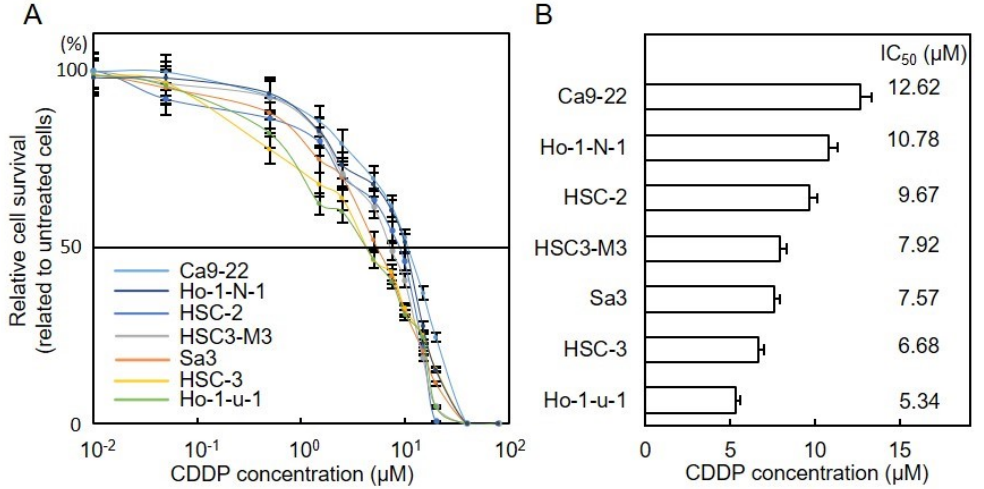
Figure 2. CDDP sensitivity of OSCC cells. ( A ) OSCC cells were seeded in 96-well plates at a density of 1 × 10 4 viable cells/well and treated with CDDP (0.01–1000 µ M) for 48 h, followed by assessment of cellular viability. Values are expressed as the mean ± standard error of the mean in relation to untreated cells. ( B ) Half-maximal inhibitory concentrations (IC 50 ) of CDDP in OSCC cells. The most resistant IC 50 to CDDP, 12.62 µ M (Ca9-22); the most sensitive IC 50 to CDDP, 5.34 µ M (Ho-1-u-1). CDDP, cisplatin; OSCC, oral squamous cell